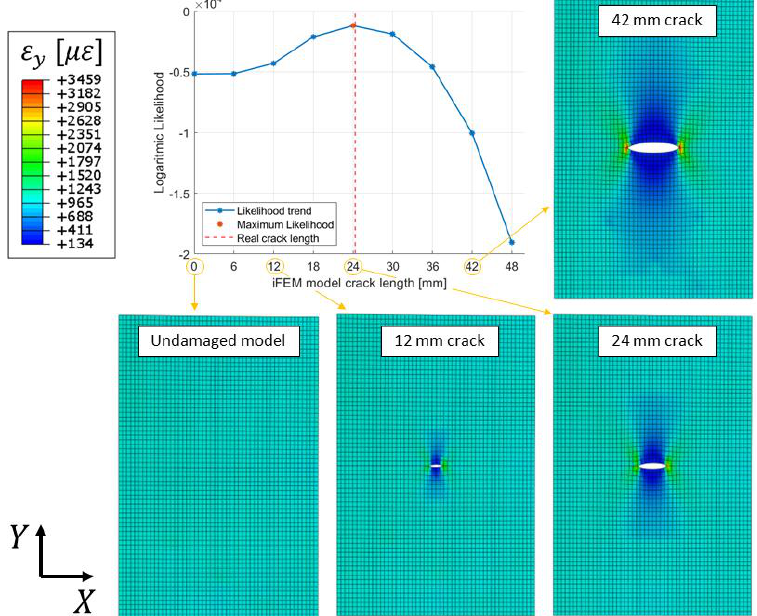
Figure 12. Likelihood trend for experimental strain acquired at a 24.3 mm crack length. Strain field computed by the iFEM for four different models; deformed shape with scale factor 100 .